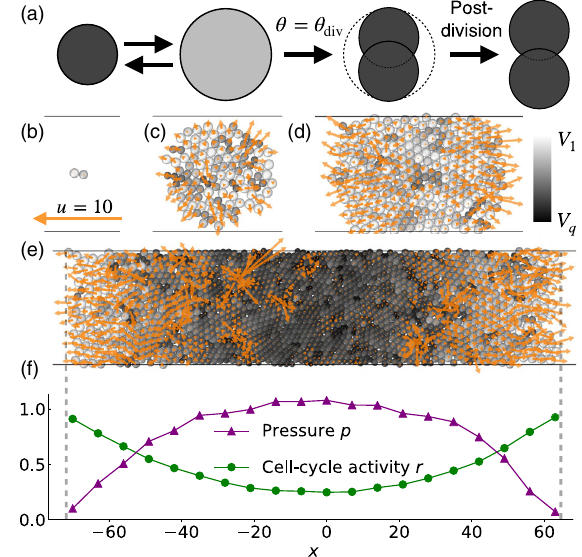
FIG. 2. Overview of 2D particle-based simulations. (a) Illus- tration of cell division and growth, with darker colors indicating smaller volumes throughout. Cells grow in size when the cell- cycle activity is high but can shrink if the cell cycle slows, due to elevated local pressure according to Eq. (6) (left and right arrows). When (if) the cell cycle reaches M phase at θ the cell divides. Each daughter cell inherits half the mother ’ s current volume (area in 2D), initially overlapping so as to occupy the mother ’ s spatial footprint. The daughters repel one another and rapidly separate. (b) – (d) The colony grows in time, from just after the first cell divides in (b) reaching approximately 1500 cells in (d). Yellow arrows represent instantaneous cell velocities; velocity u ¼ 10 (in dimensionless units of key in (b). (e) Growth fronts later develop at the left or right